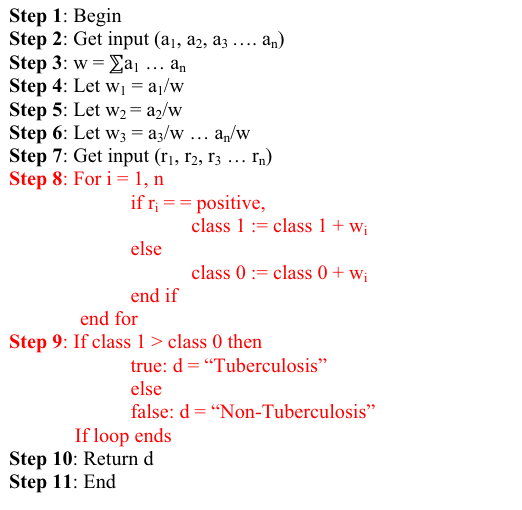
Figure 3. Extended weighted voting ensemble algorithm.